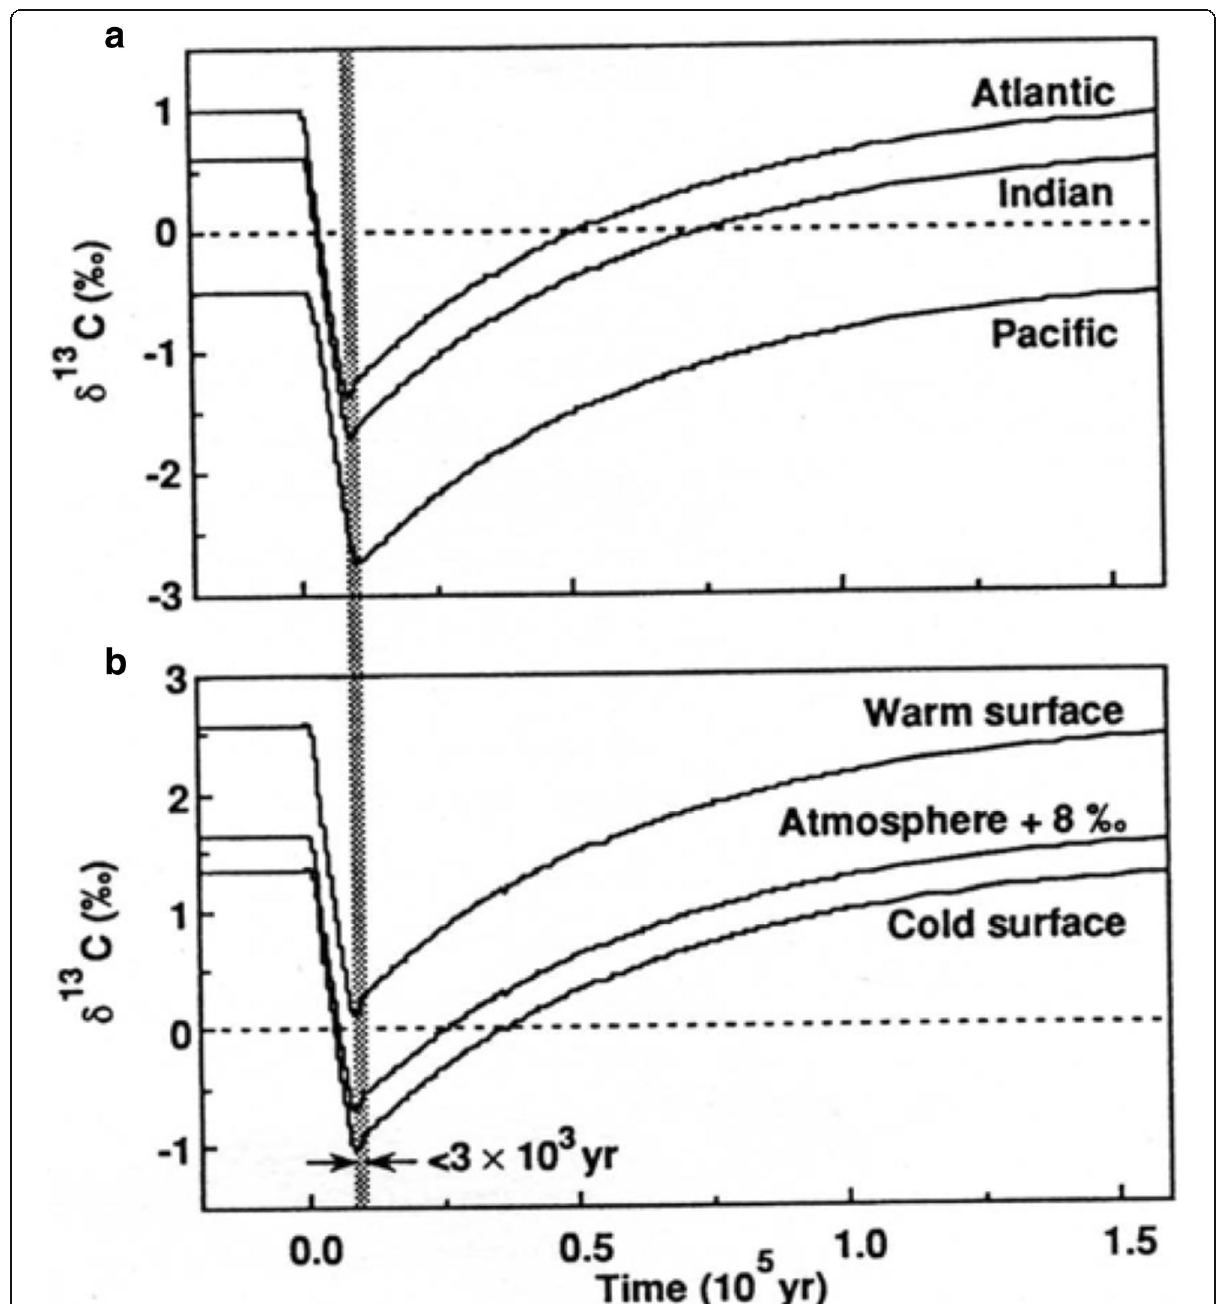
Fig. 18 Effect of methane release with a δ 13 C of − 60 ‰ over 10 kyr on the δ 13 C value of present-day preindustrial carbon reservoirs. a Response of δ 13 C in deep water of the Atlantic, Indian, and Pacific Oceans. Initial values are 0.996 ‰ , 0.620 ‰ , and − 0.508 ‰ , respectively. b Response of δ 13 C in warm surface water, cold surface water, and the atmosphere (shifted by +8 ‰ ). Initial values are 2.577 ‰ , 1.355 ‰ , and − 6.367 ‰ , respectively (modified from Dickens et al.